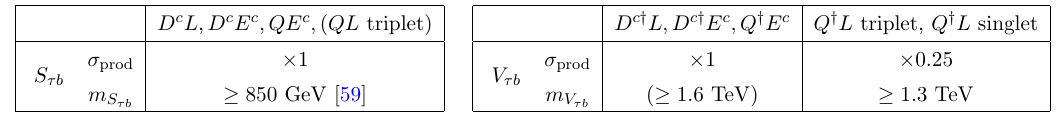
Table 10 . 95% CL lower limits on the mass of MLQs which decay into ( (cid:28)b )( (cid:28)b ) (cid:12)nal states for the scalar leptoquarks ( left ) and the vector leptoquarks ( right